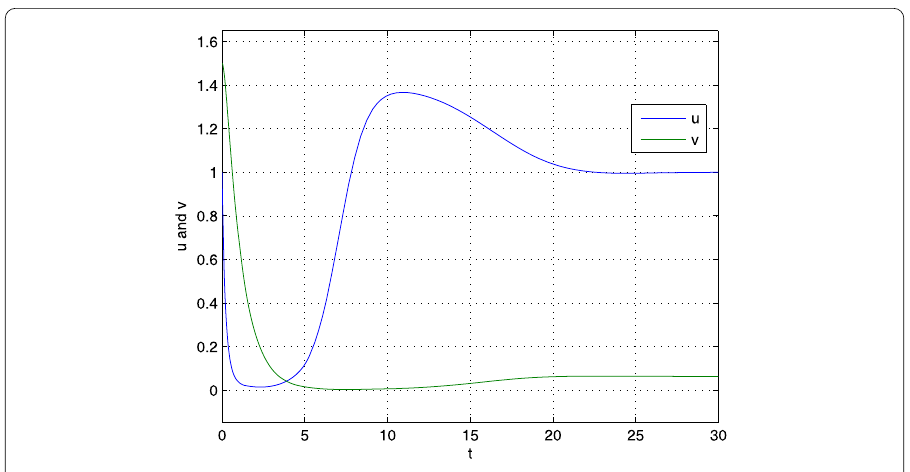
Figure 12 Dynamic behavior of system (1.1) with r 0 = 4, d = 1, a = 1, p = 2, E = 1, m 1 = 1, m 2 = 0.1, c = 0.5, k = 1, and q = 18